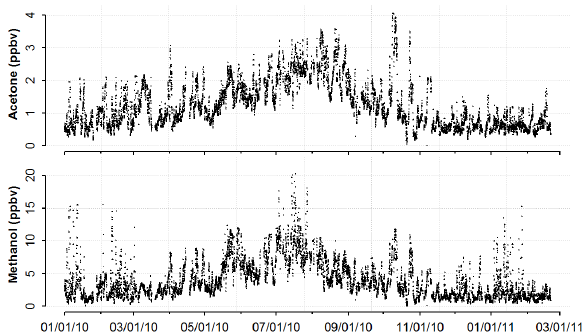
Figure 2. Annual cycle in atmospheric acetone and methanol observed at the KCMP tall tower 3 Fig. 2. Annual cycle in atmospheric acetone and methanol observed from January 2010 through February 2011. All data points are 1 h averages. Statistical outliers (> 4 at the KCMP tall tower from January 2010 through February 2011. 0.98 quantile for each month) have been removed prior to plotting. 5 All data points are 1h averages. Statistical outliers ( > 0.98 quantile for each month) have been removed prior to plotting.